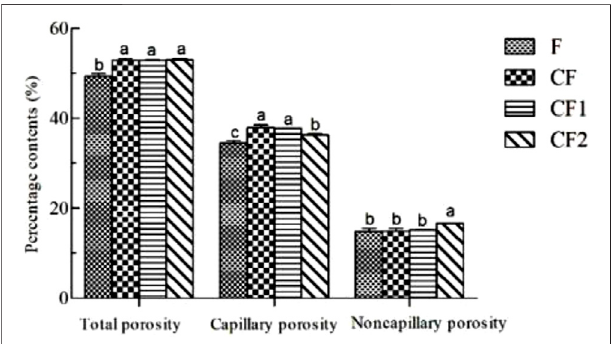
FIGURE 2 | Effect of co-application of biochar and chemical fertilizer on soil